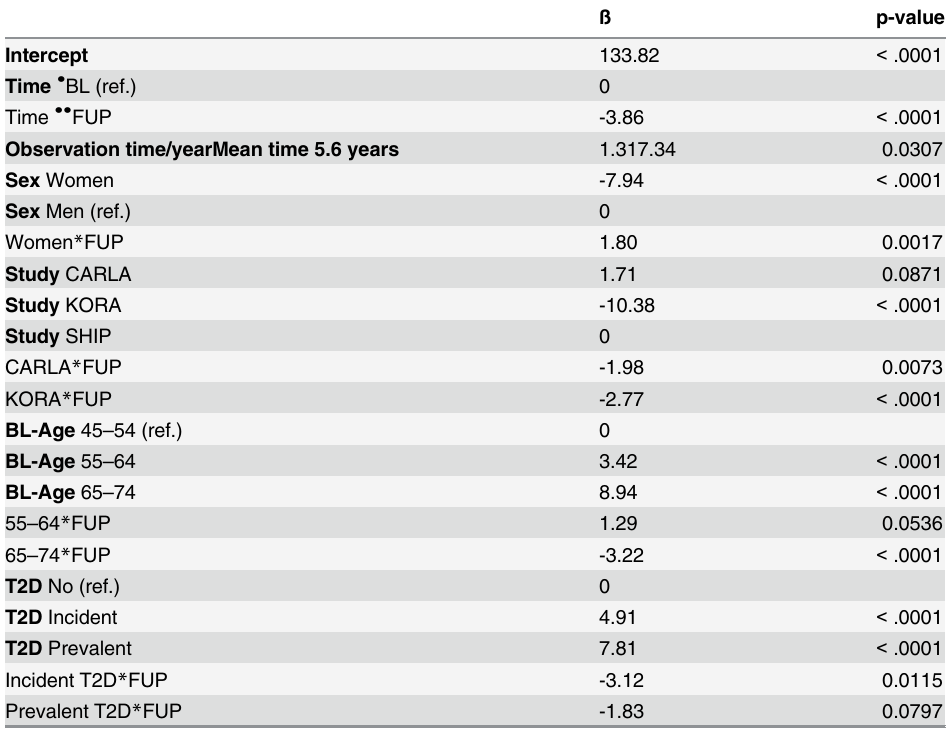
Table 4. Linear mixed model including observation time, sex, BL-age, study, FUP-T2D and interaction terms with time as covariates and systolic BP as outcome (N = 4683, complete case dataset). ß p-value Intercept 133.82 < .0001 Time ● BL (ref.) 0